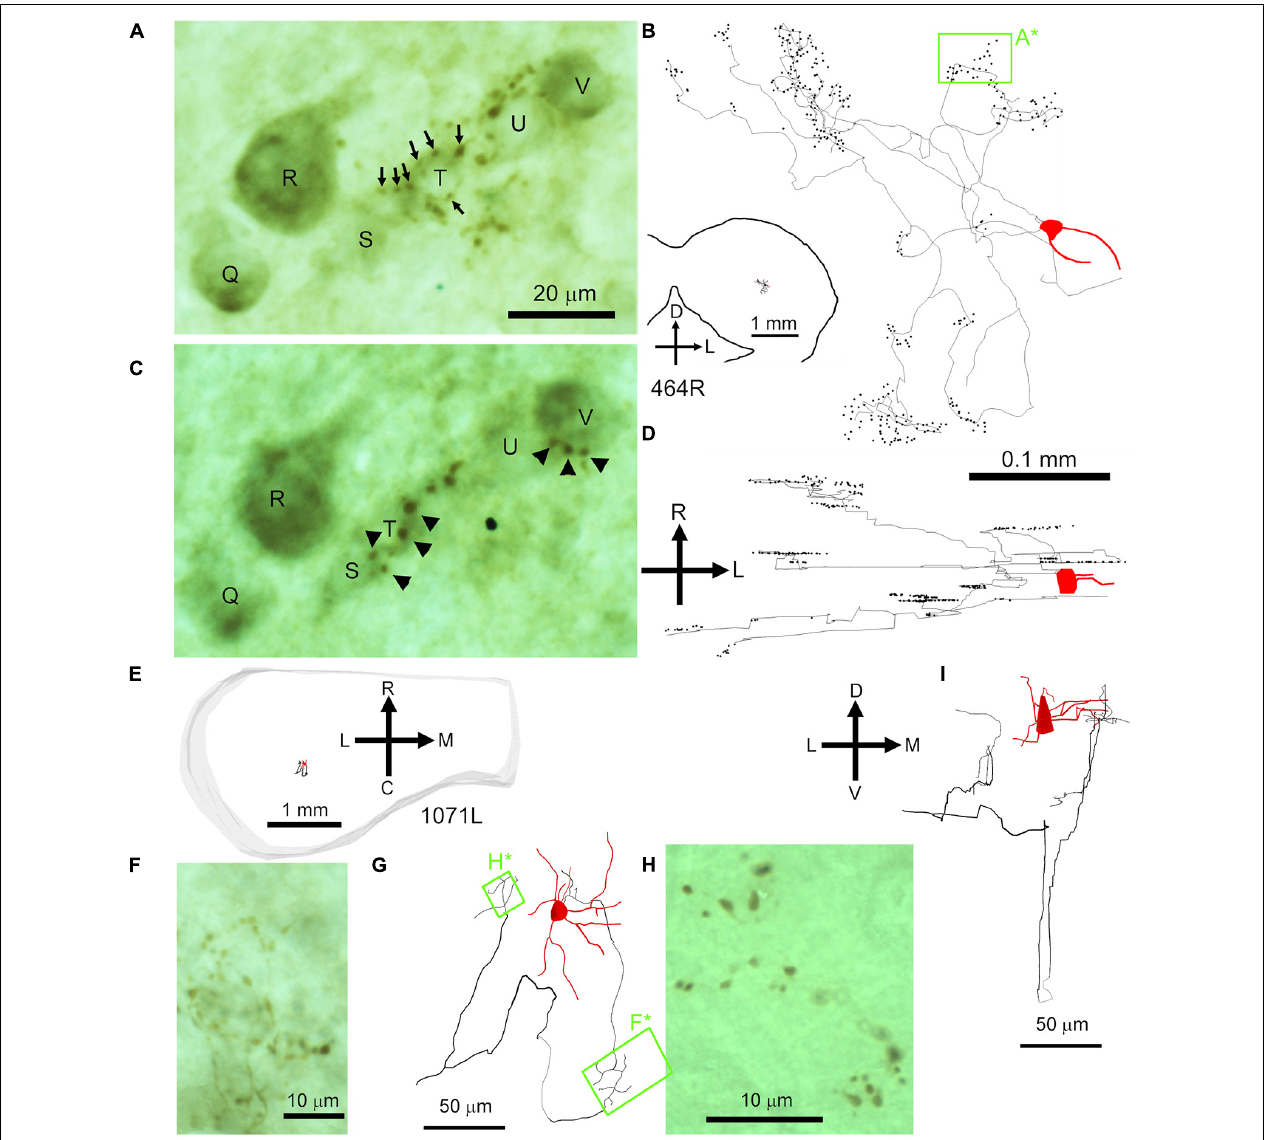
FIGURE 9 | Basket-like axonal endings of two medium flat stellate cells with chopper-like firing responses. The first cell (464R) was located in the central nucleus of the right IC and sectioned in the coronal plane as shown in the inset in panel (B) . (A) High power view of stained axonal swellings that seem to form baskets surrounding the somata of some nearby cells. These somata can be weakly discerned because of background staining and are labeled Q–V. Some of the swellings associated with soma T are indicated by the small arrows. (B) Coronal reconstruction of filled cell with the axonal swellings shown as black dots. The arrows indicate the dorsal (D) and lateral (L) orientations and are positioned over the IVth ventricle. The position of the cells shown in panels (A,C) has been indicated by the pale green rectangle (A*). (C) The same cells are viewed at a more shallow plane of focus than panel (A) to show a different set of axonal swellings, some of which are indicated by arrowheads. Two of the indicated endings seem to be associated with cell S, two with cell T and three with cell V. (D) Reconstruction of the same cell shown in the horizontal plane with the rostral (R) direction indicated by the arrow. (E) Location of second chopper cell (1071L) in central IC with basket-like axonal endings sectioned in the horizontal plane. (F) Basket–like arrangement of faintly stained axonal swellings that may be arranged around three adjacent somata. (G) Reconstruction, in the horizontal plane, of the stained cell showing the location of the adjacent panels (F* and H*). (H) Photograph of tightly arranged groups of axonal swellings. (I) Coronal reconstruction of the filled